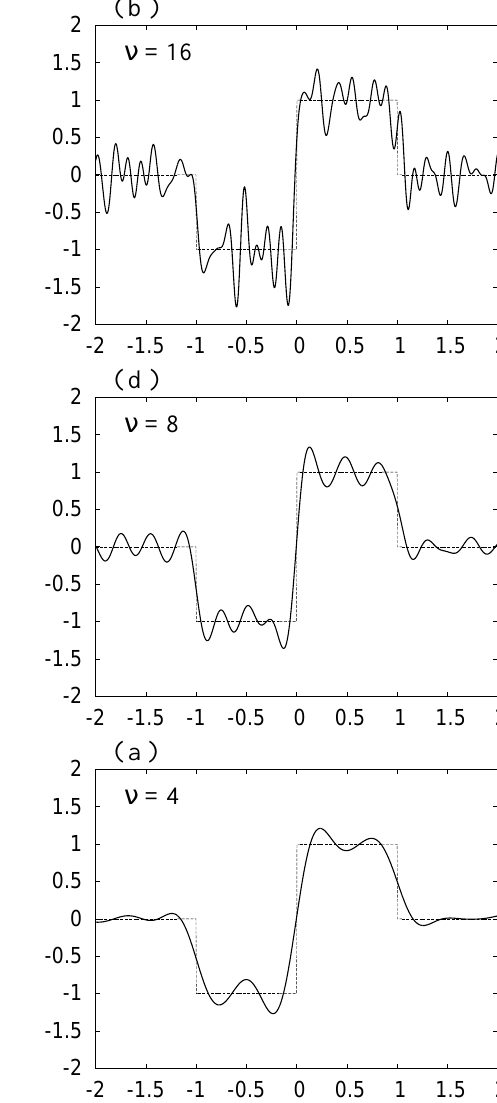
Figure 8. ( a ), ( c ), ( e ): M the mollifier µ curves show M